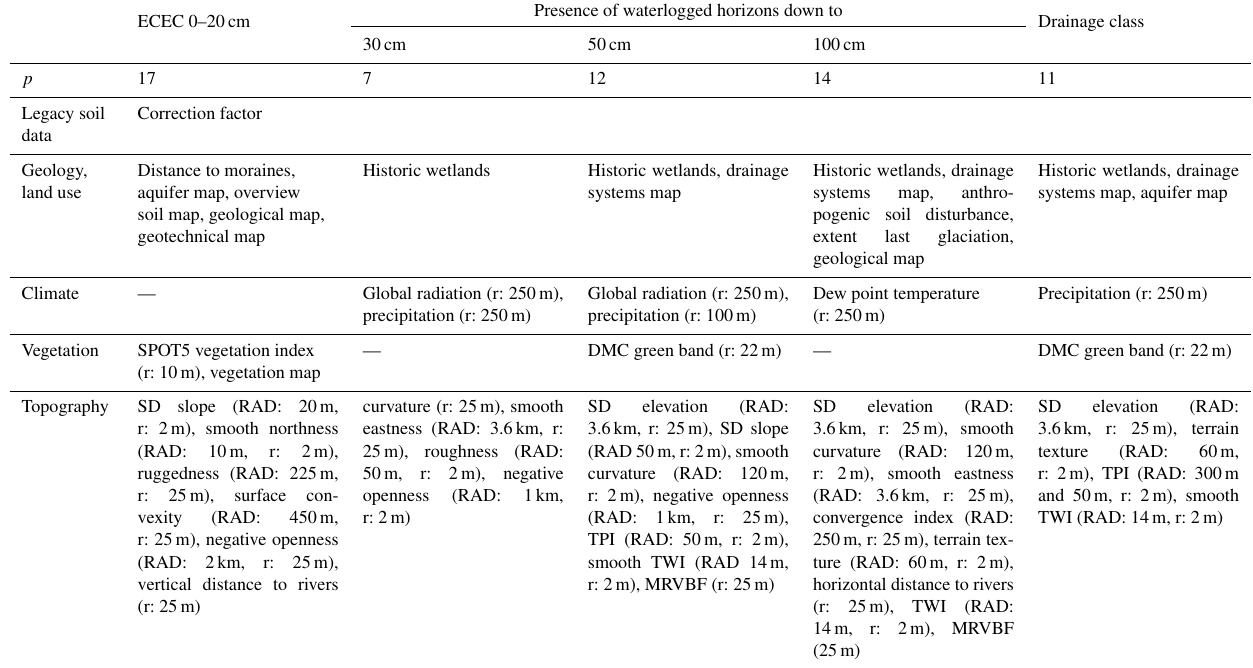
Table 2. Covariates contained in final geoGAM for responses ECEC, the presence of waterlogged horizons and drainage classes. More details on covariate effects can be found in Figs. S1 and S4 to S6 in the Supplement ( p : number of covariates, SD: standard deviation in a moving window, RAD: radius of moving window or parameter of terrain attribute algorithm, r: resolution of elevation model, TPI: